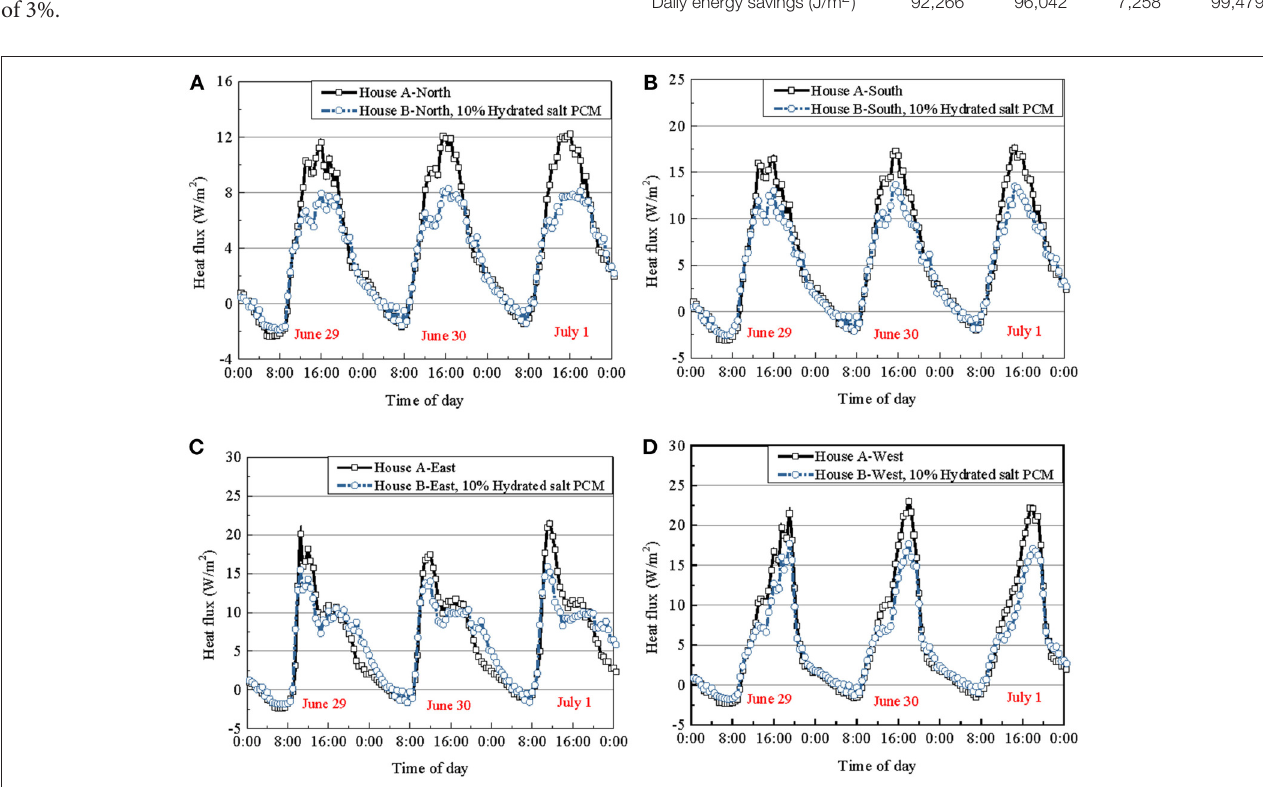
FIGURE 4 | Heat flux through exterior frame walls with 10 wt% PCMs. (A) North-facing walls. (B) South-facing walls. (C) East-facing walls. (D) West-facing walls.